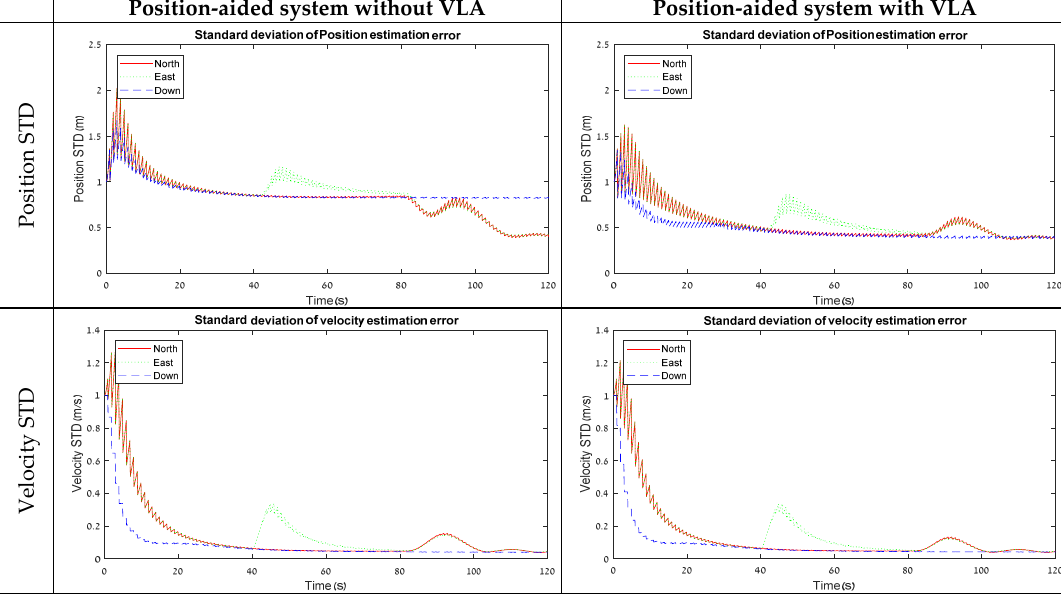
Figure 2. STD results from the software simulation for a velocity ‐ aided system with and without VLA. Position ‐ aided system without VLA Position ‐ aided system with VLA